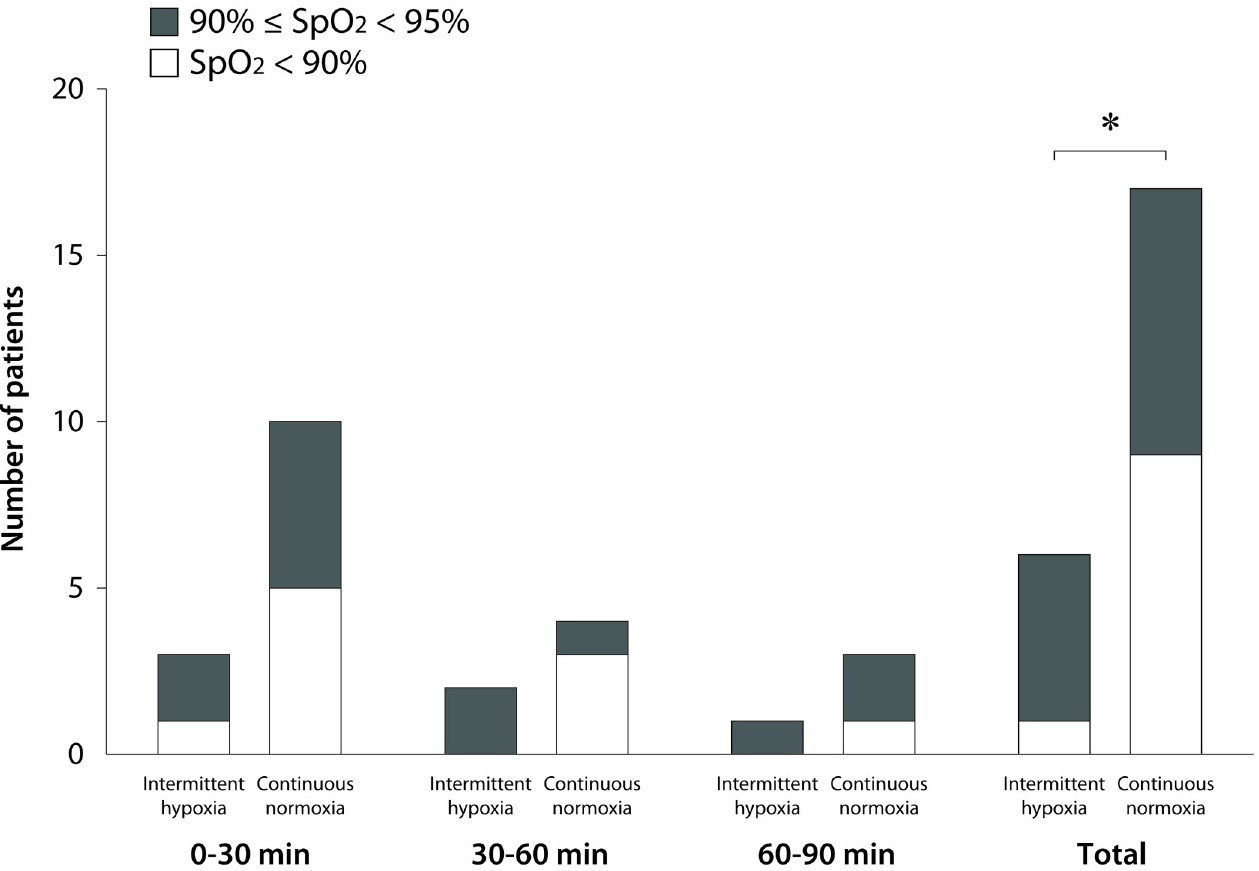
Fig 2. Number of hypoxemic patients with SpO 2 < 95% for 0–30, 30–60, and 60–90 min after starting one-lung ventilation. � 6/68 (8.8%) vs 17/68 (25.0%), risk ratio (95% CI) 0.35 (0.15–0.84), P = 0.012 by chi-squared test for SpO 2 < 95%; 1/68 (1.5%) vs 9/68 (13.2%), risk ratio (95% CI) 0.11 (0.01–0.85), P = 0.017 by Fisher’s exact test for SpO 2 <